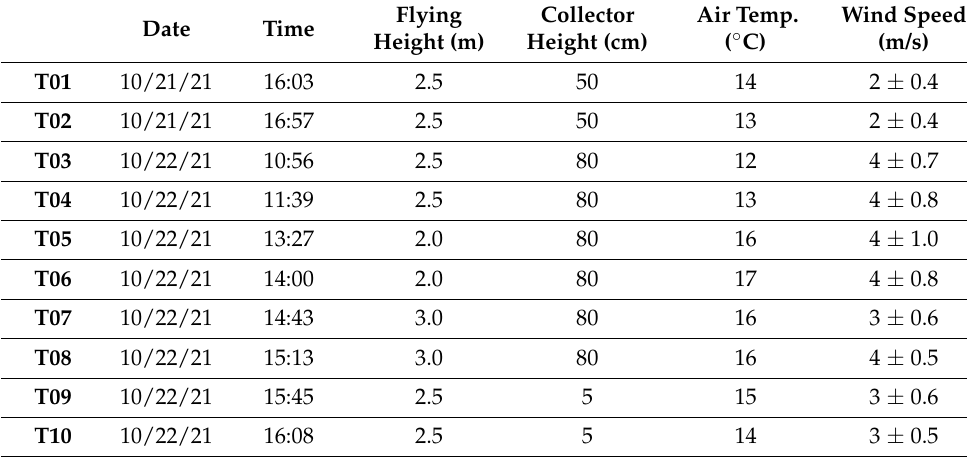
Table 1. Spray application and meteorological